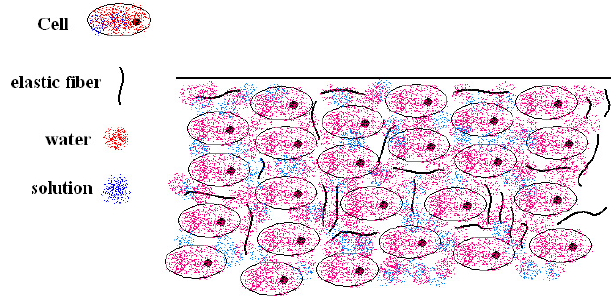
Fig. 1. Schematic of the nonlinear mixture model of